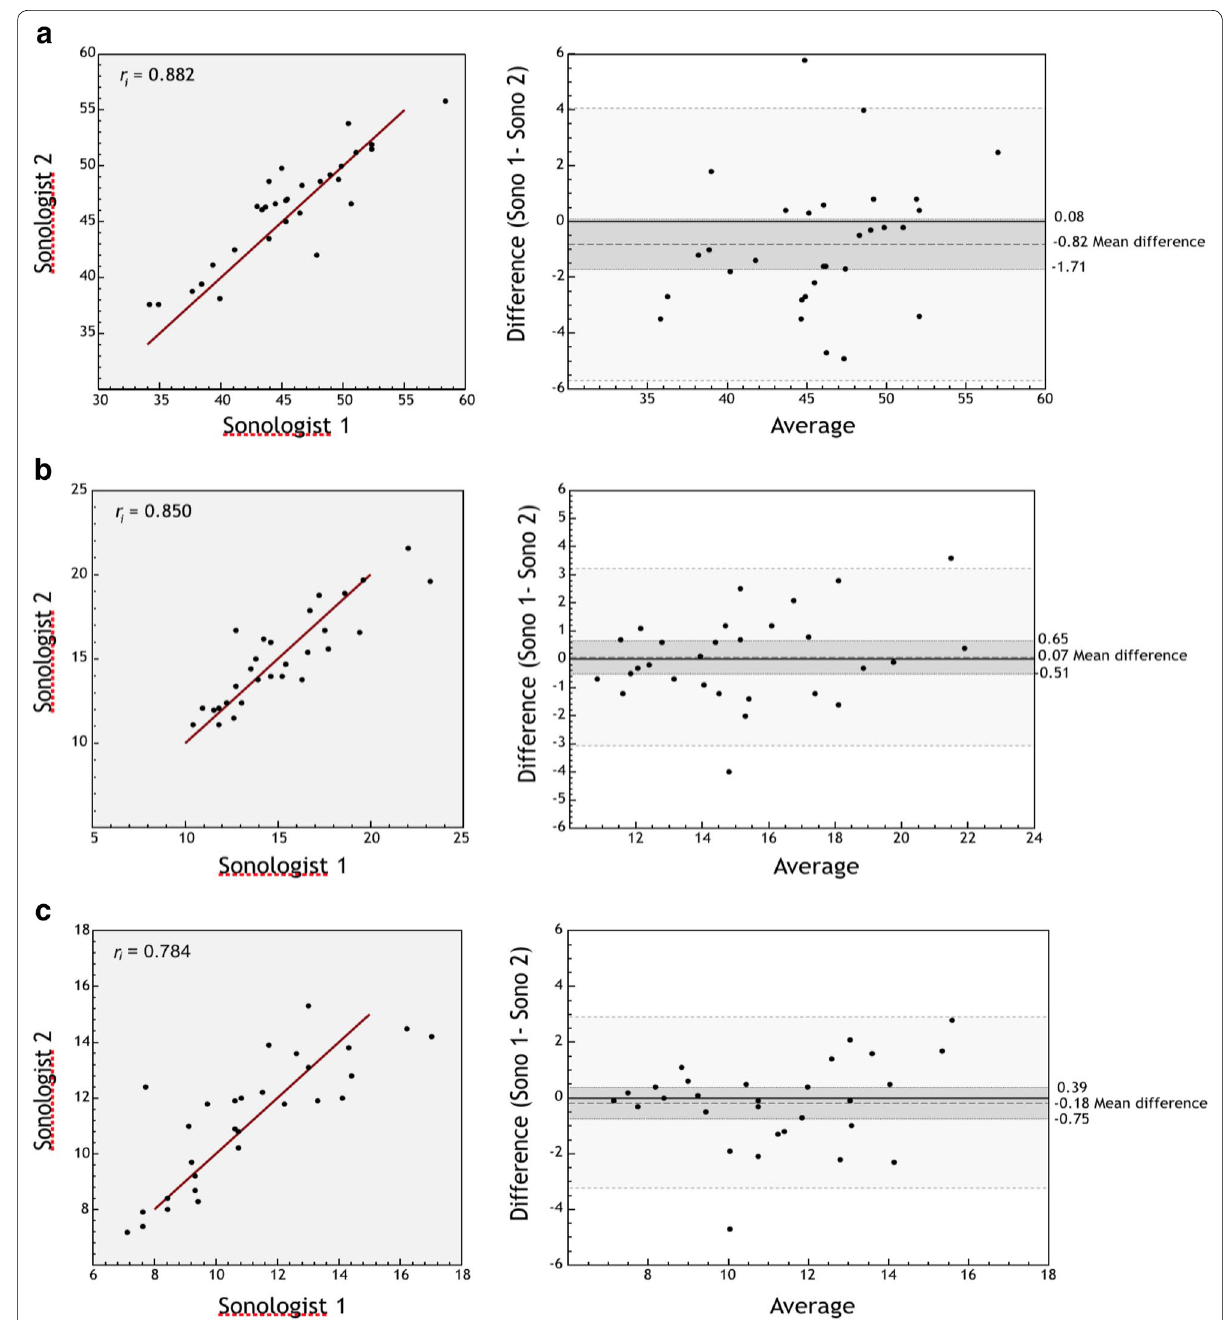
Fig. 2 ICC graphs and Bland–Altman plots: agreement between sonologists in measurements. Y axis for Bland–Altman plots represents average of sonologists measurements. Mean difference between sonologists with 95% confidence intervals on the means shown (darker gray). Lighter gray bands represent the 95% confidence bands. a Tongue base thickness (mm). b Epiglottis LA (mm). c Pre-epiglotic space